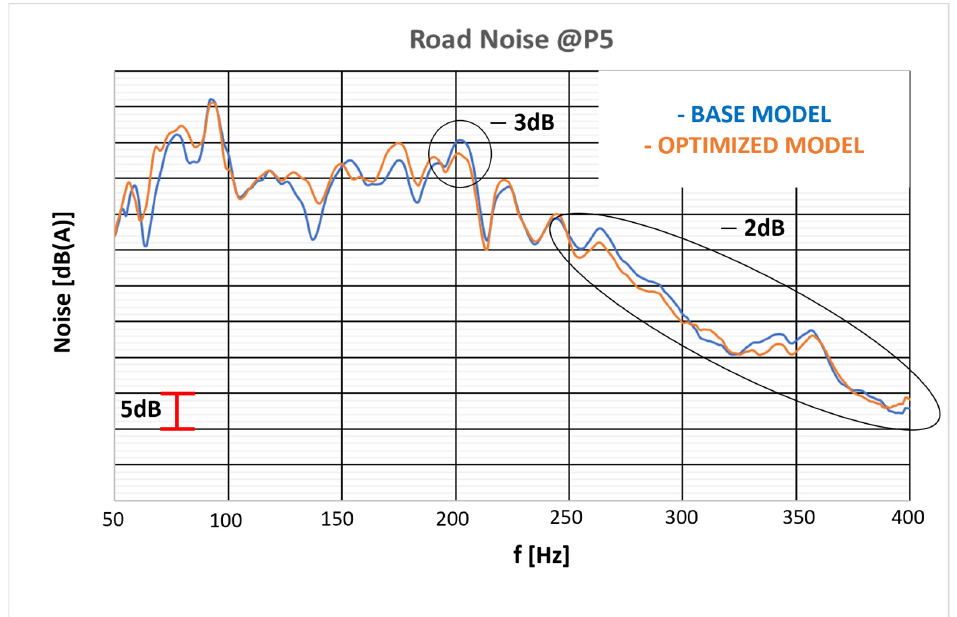
Figure 38. Acoustic pressure on MIC5 (Left ear, right rear passenger), with highlight of the frequency ranges with reduced SPL.